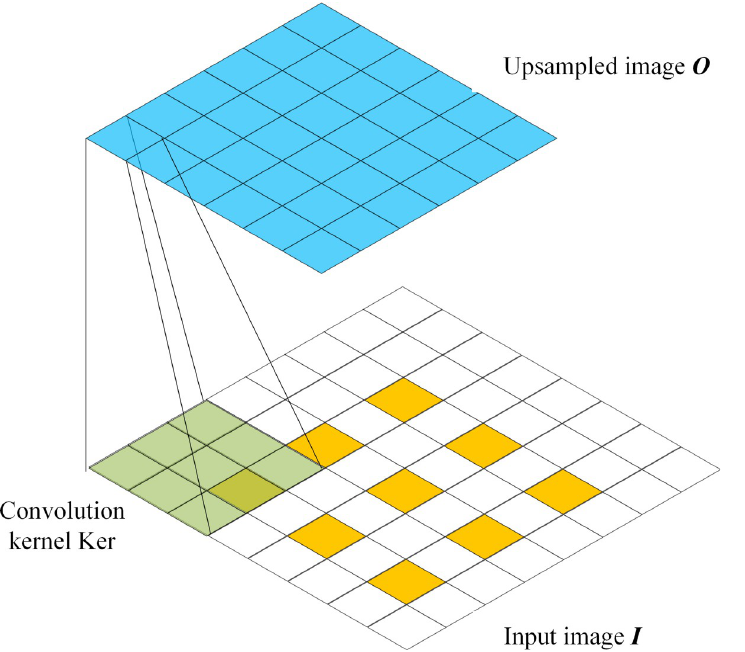
Fig 6. Deconvolution up-sampling mechanism